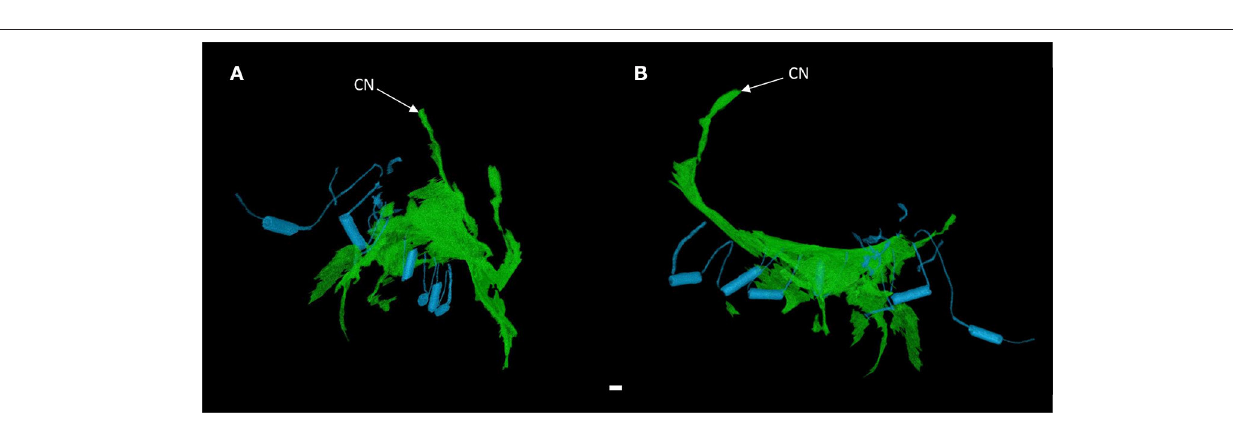
FIGURE 4 | 3-dimensional rendering of the atrioventricular conduction axis in a heart with atrioventricular septal defect (AVSD). Showing the conduction axis (green) and the surgically placed pledgets and sutures (blue) in anterior (A) and right lateral views (B) . Images derived from segmentation of micro-CT data. CN, compact atrioventricular node. Scale bar represents